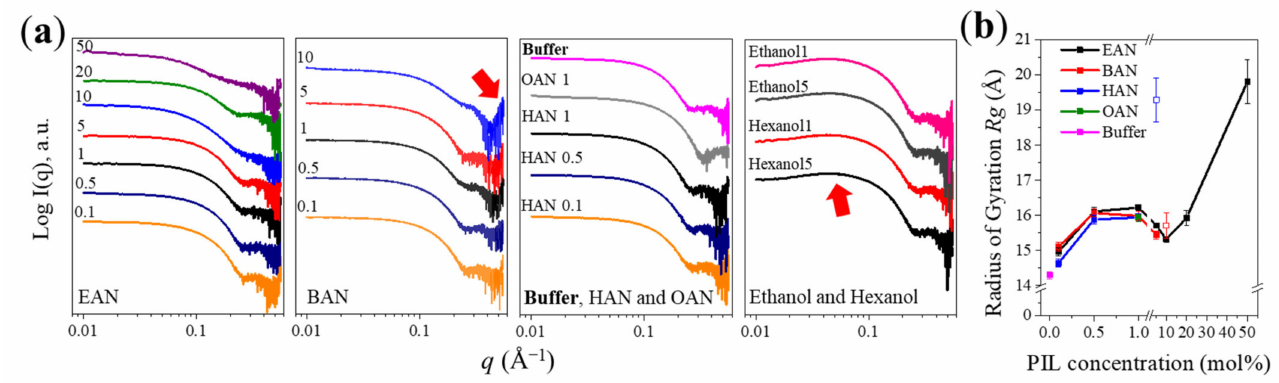
Figure 4. SAXS profiles of lysozyme in different solvents (i.e., EAN, BAN, HAN, OAN, buffer, ethanol and hexanol-water mixtures) ( a ) and the R g values as a function of PIL concentration ( b ). The numbers on the plots refer to the PIL and alcohol concentration in mol%. The arrow in BAN 10 mol% solution illustrates the contribution of PIL nanostructure, while the arrow in ethanol and hexanol solutions refers to the downturn at low q owing to the repulsive inter-particle interactions. The R g of lysozyme in 10 mol% BAN and 5 mol% HAN solutions (open square) is an estimate, since the SAXS patterns were affected by subtraction issues due to PIL nanostructure (Figure S2, Supplementary Materials). The Guinier plots used for calculating R g are provided in Figure S3 (Supplementary Materials), and the data analysis details are presented in Table S2 (Supplementary